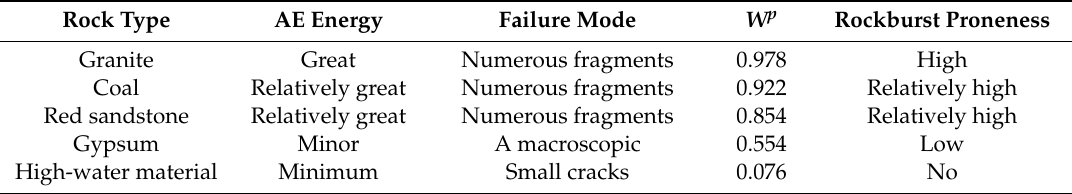
Table 6. The failure characteristics of five rock